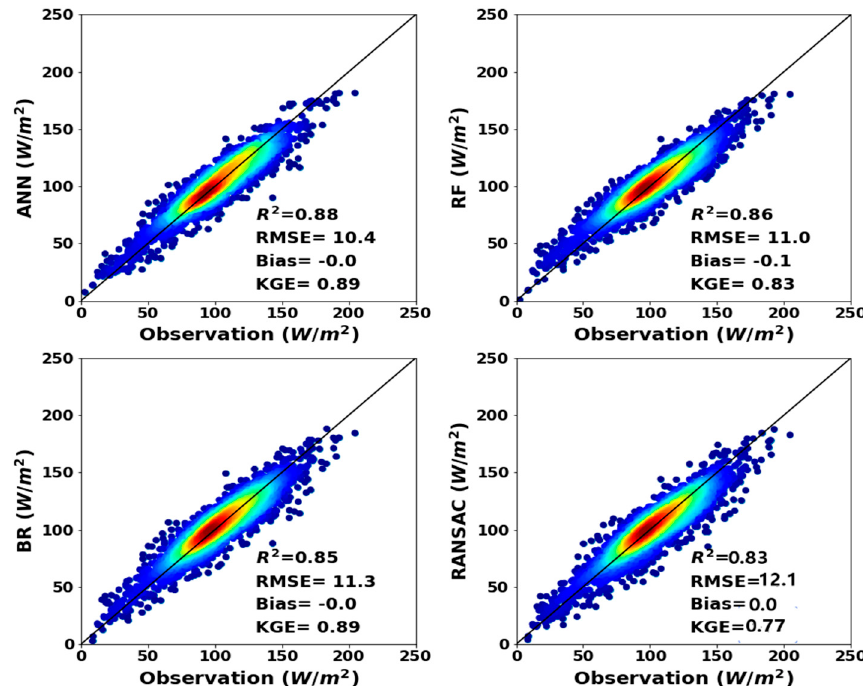
Figure 5. The scatter plots for ocean LHF observations at 81 training buoy sites and LHF estimates from the ANN , RF , BR and RANSAC methods during 2003–2007 (unit W m − 2 ).